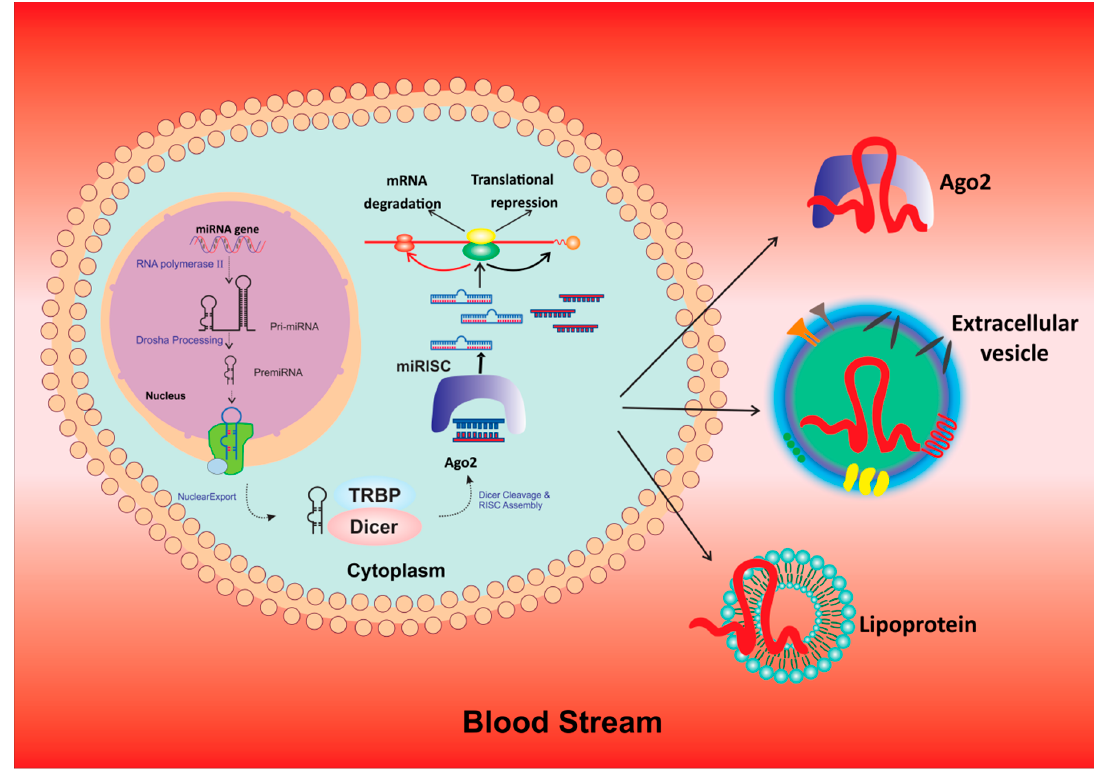
Figure 1. Process of biogenesis of miRNAs in the nucleus, its transfer into cytoplasm and functions.